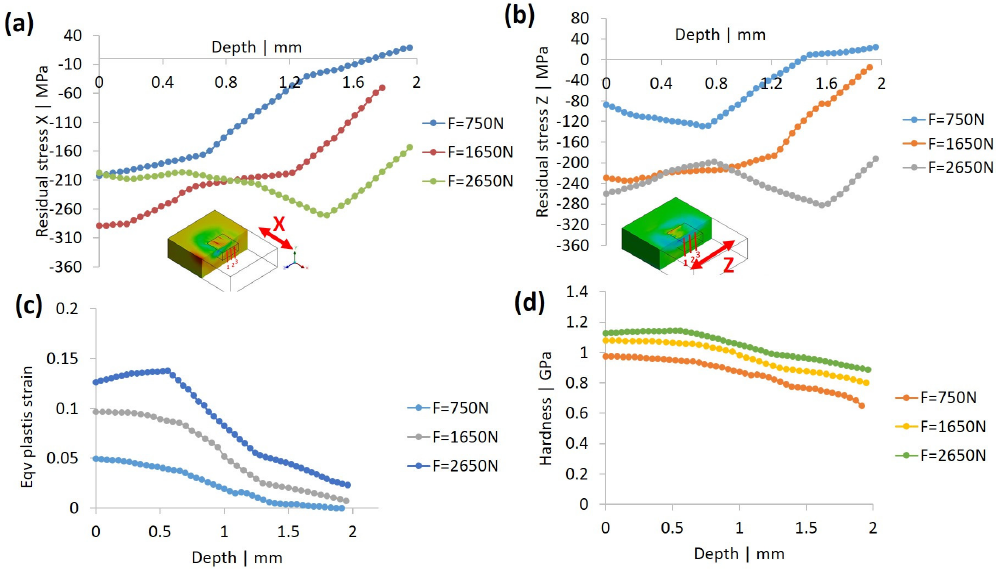
Figure 12. Effect of burnishing force on ( a ) residual stress along X (feed direction); ( b ) residual stress along Z (step-over direction); ( c ) plastic strain and ( d ) hardness at f = 300 mm/min and S = 0.10 mm.